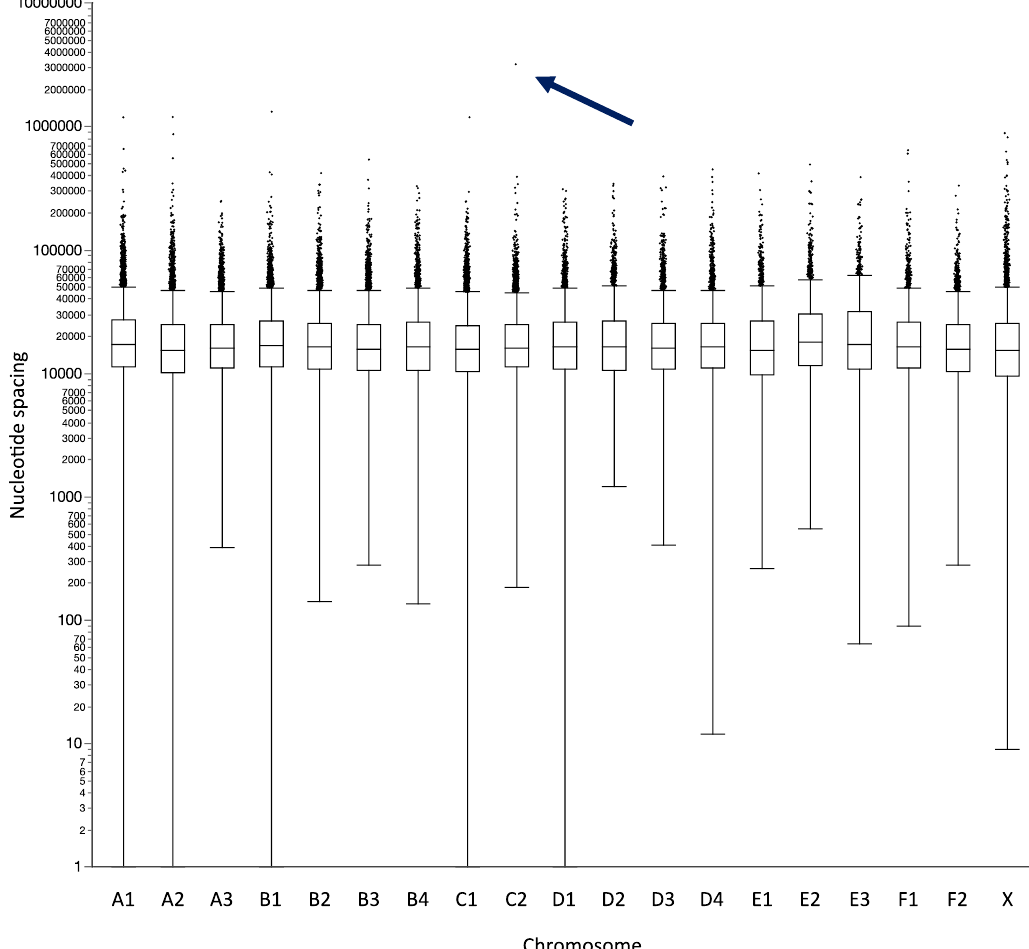
Figure 1. Outlier plot summarizing probe spacing on the feline oligonucleotide array comparative genomic hybridization (oaCGH) array. The x-axis shows each feline autosome and the X chromosome, and the y-axis shows the nucleotide intervals between consecutive probes on each chromosome, using a logarithmic scale. Each box delineates the interquartile range of interval sizes between probes, showing that 50% of all intervals lie within a close range of approximately 10kb to 30kb. The central horizontal bar within the interquartile range indicates the median probe spacing for that chromosome. This demonstrates the global uniformity of probe distribution, with median spacing ranging from 15.4kb (fcaE1) to 18.1kb (fcaE2), and an overall mean genome-wide spacing of 22.6kb. The vertical bars extending from each box define the minimum and maximum distances between two consecutive probes, excluding large ‘outlier intervals’, which are shown as individual datapoints. Outliers are defined as intervals that are larger than the 3rd quartile value + 1.5x the interquartile range. The ~3.2Mb outlier interval on fcaC2 (arrowed) resulted from loss of a cluster of probes mapping to a large scaffold in the preliminary felCat5 assembly that could not be integrated reliably into the more advanced felCat9 assembly. Table 1. Summary of probe distribution on the feline oaCGH array. The physical size of each chromosome is shown along with the corresponding number of validated probes developed for the final array design. The mean and median probe spacing demonstrates the global comparability of probe distribution for each chromosome, with an overall 22.6kb spacing at the genome-wide level, equating to an average of 44 probes per Mb of sequence. The lower values for maximum spacing on fcaF1 and F2 reflect the acrocentric nature of these chromosomes, while the remaining chromosomes, all of which are biarmed, are impacted more heavily by the confounding effect of centromeric repeat sequence on probe design.